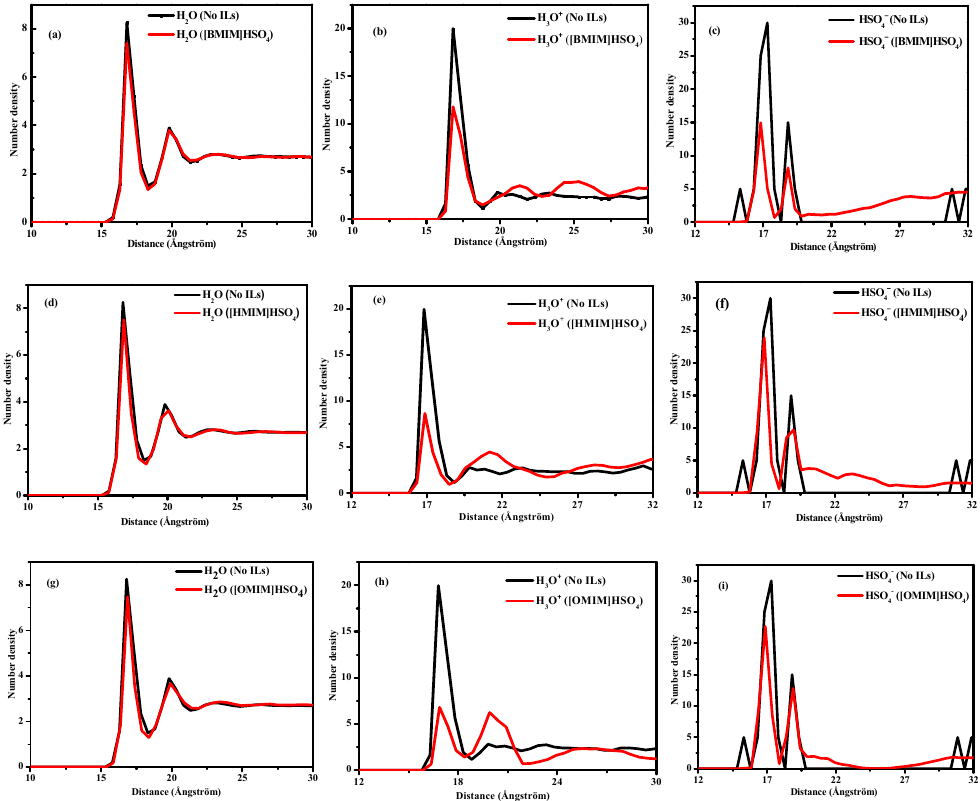
Figure 10. Number density profiles from the molecular dynamics simulations for H 2 O, H 3 O + , and HSO 4 − on the Cu(111) surface with and without ionic liquids of [BMIM]HSO 4 ( a – c ), [HMIM]HSO 4 ( d – f ), and [OMIM]HSO 4 ( g – i ). It can be seen from Figure 10a,c,d that when three ILs are added, the first peak value of the H 2 O molecular number density curve decreases, which means that the addition of inhibitor molecules leads to a decrease in the H 2 O molecular number density on the copper surface. From the number density curves of H 3 O + and HSO 4 − , we found that the addition of the ILs inhibitors leads to a significant decrease in the number density of H 3 O + and HSO 4 − on the copper surface. From the discussion in Section 2.1, the ILs are adsorbed on the Cu(111) surface with the -C=N- of the imidazolium ring, O and S atoms in HSO 4 , to form a protective film that blocks the transfer of oxygen and corrosive particles from the bulk solution to the copper/solution interface, which is in good agreement with the experimental deduction in ref [1]. The results show that the longer the branched-chain of the ionic liquid, the stronger the interaction between the ILs and Cu(111) surface, and the closer the adsorption, which hinders the contact between the Cu(111) surface and corro- sive particles and greatly slows down the corrosion rate of corrosive ions on the copper surface. 2.3. QSAR of Reactive Parameters and the Inhibition Efficiency of Three ILs The inhibition efficiency ( IE ) of alkylimidazolium ILs was obtained by electro- chemical impedance spectroscopy (EIS) measurements in 0.5 M sulfuric acid solution by Zhang et al. [1]. The total inhibition efficiency of three ILs inhibitors in each concentration is correlated with the reactive parameters from the quantum chemical calculation with the linear and nonlinear QSAR models of Equations (8) and (9). The linear results are shown in Equations (2) and (3), while the nonlinear results are given in Equations (4) and (5). It can be seen that the linear regression is not well. For the nonlinear regression, we